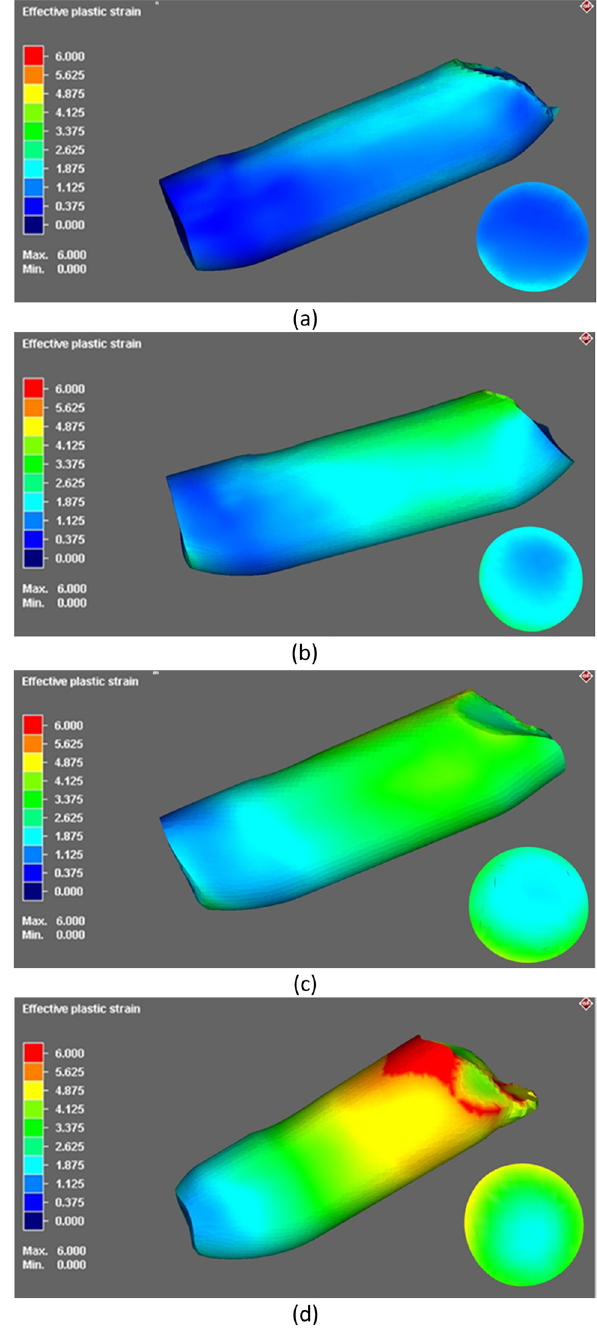
Figure 6: Strain distribution along both the LS and TS of the Cu billets processed through ECAP using the 120° - die through 1 - P